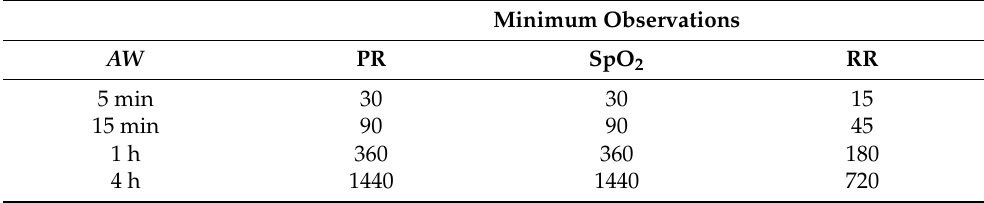
Table A1. Minimum number of observations for each aggregation window ( AW